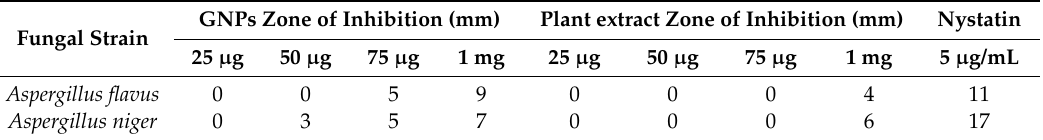
Table 4. Antifungal assay of extract and